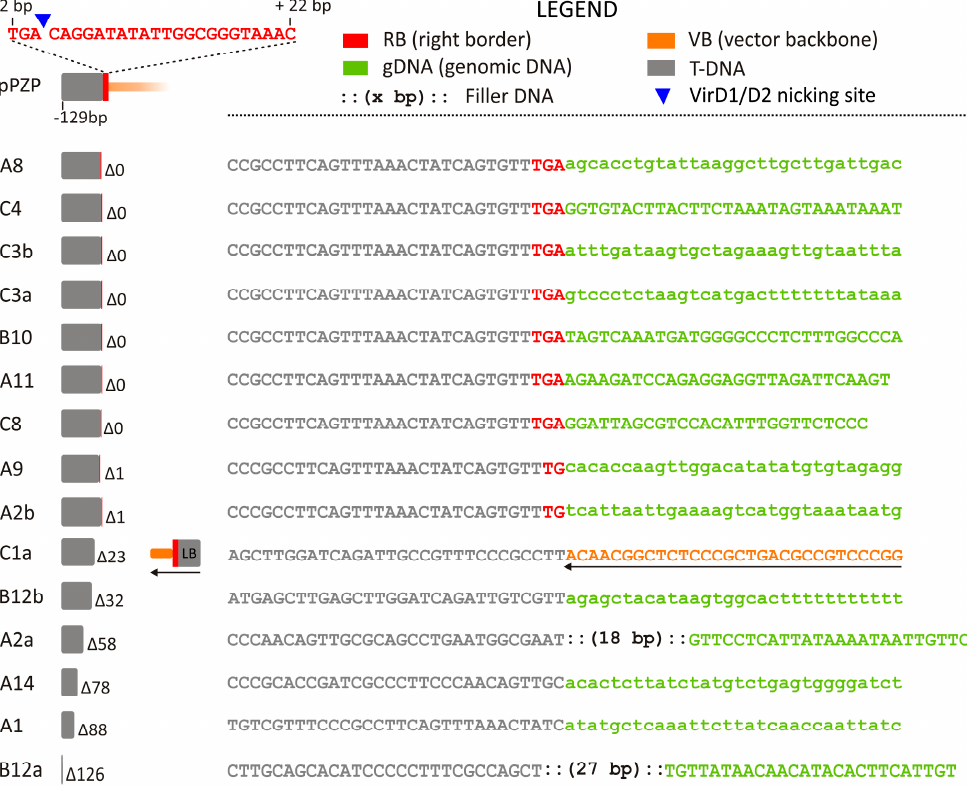
Figure 2. Analysis of the right border (RB) junctions. Color codes are shown in the legend and a pPZP RB model, in scale, is provided in the upper left corner. From left to right, each junction is described by: (1) an alphanumeric code identifying the transgenic event, if multiple junctions are isolated from the same event, these are identified by a lowercase letter; (2) a graphical representation, in scale, of the rearrangement occurred during integration at the RB, along with the number of the deleted ( Δ ) bp, in comparison with the expected intact T-DNA sequence; (3) the sequence showing the 30 bp 5 ′ and 3 ′ of the junction; letters in lowercase indicate putative gDNA sequences (not verifiable by BLAST analysis, Table S1) Letters in red identify bases belonging to the RB.